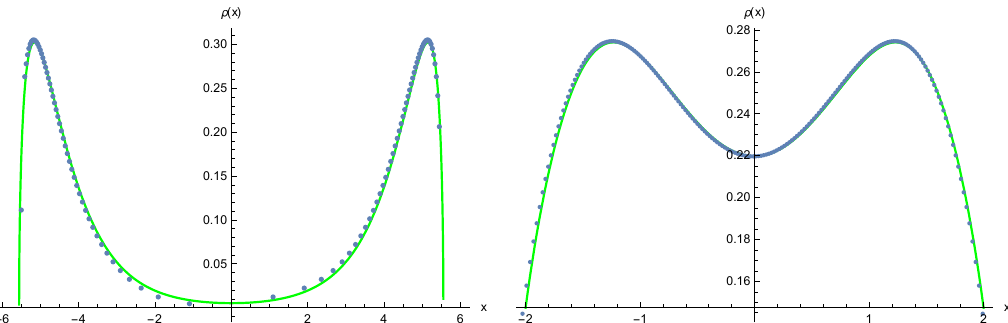
Figure 2 . These (cid:12)gures show the numerical solution (blue dots) and analytic solutions for (cid:26) ( x ) (green line). The left utilizes the parameter ( N; N f ; m )=(100,2000,2), and the right one is for parameter ( N; N f ; m